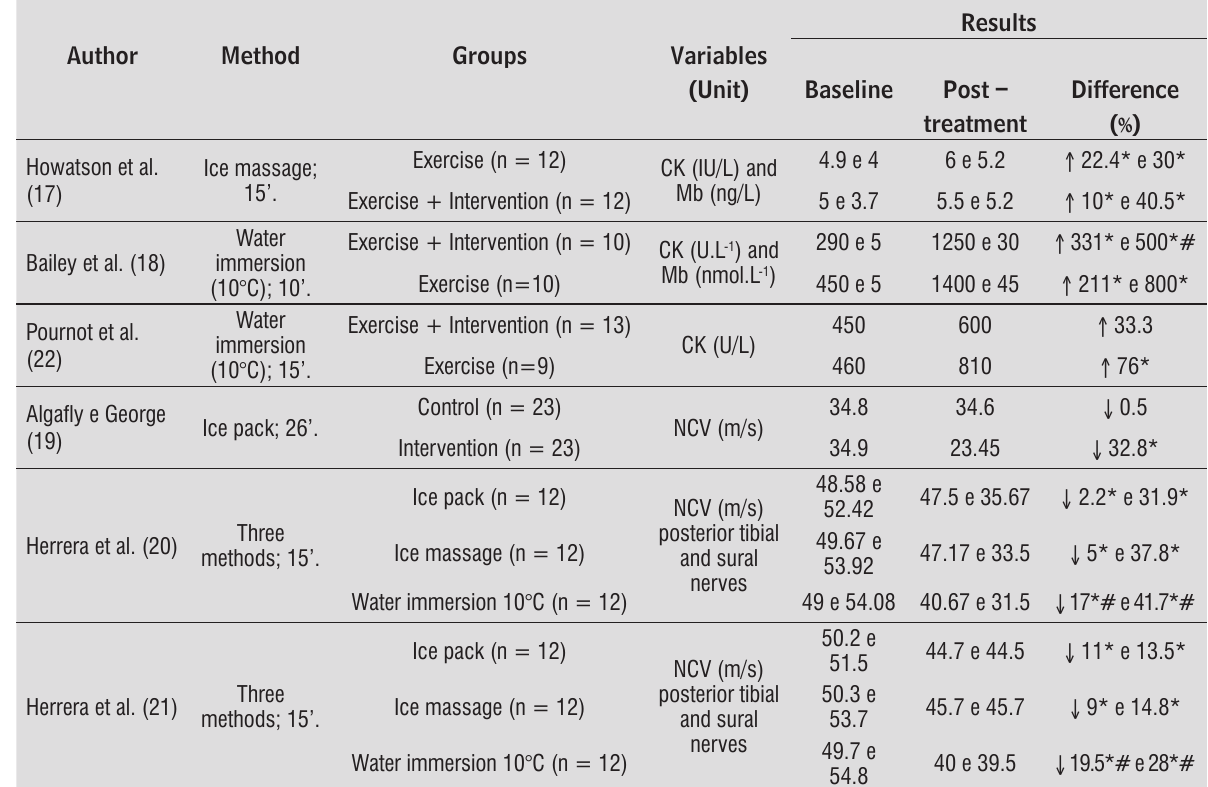
Table 3 - Effects of cryotherapy on inflammatory and neural